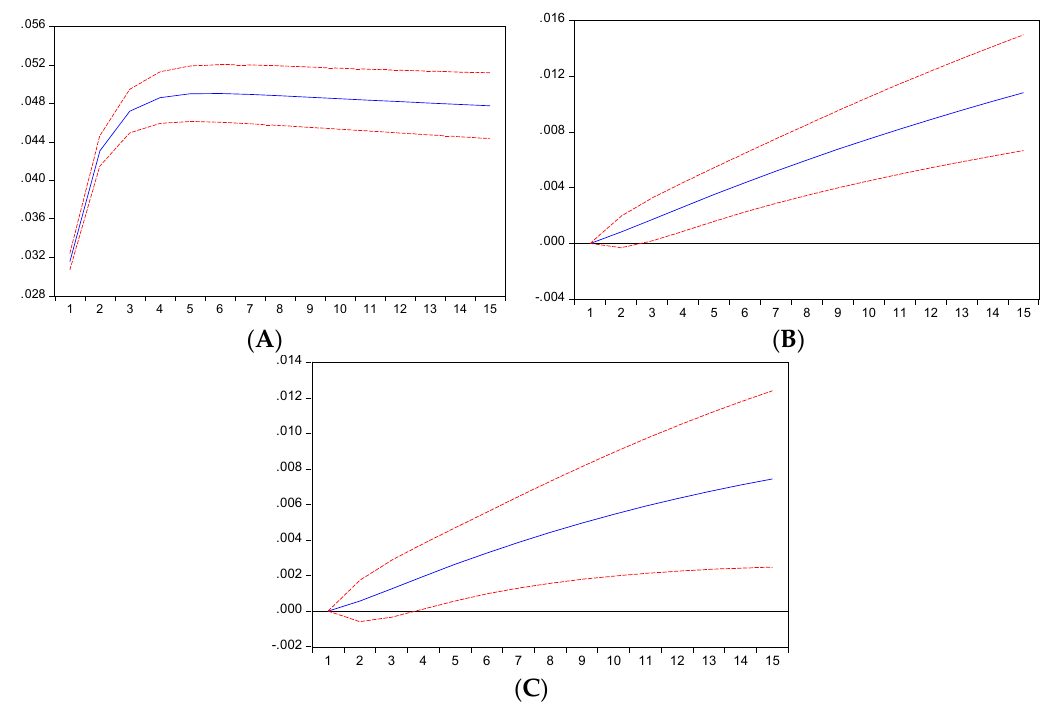
Figure 2. Impulse response function (IRF). ( A ) Response of lnFP to lnFP; ( B ) Response of lnFP to lnEP; ( C ) Response of lnFP to lnEX.